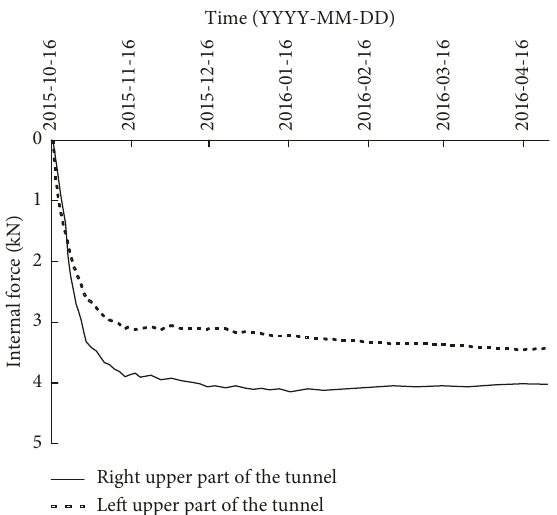
Figure 11: Internal stress-time curves of the surrounding rock at the cross section of